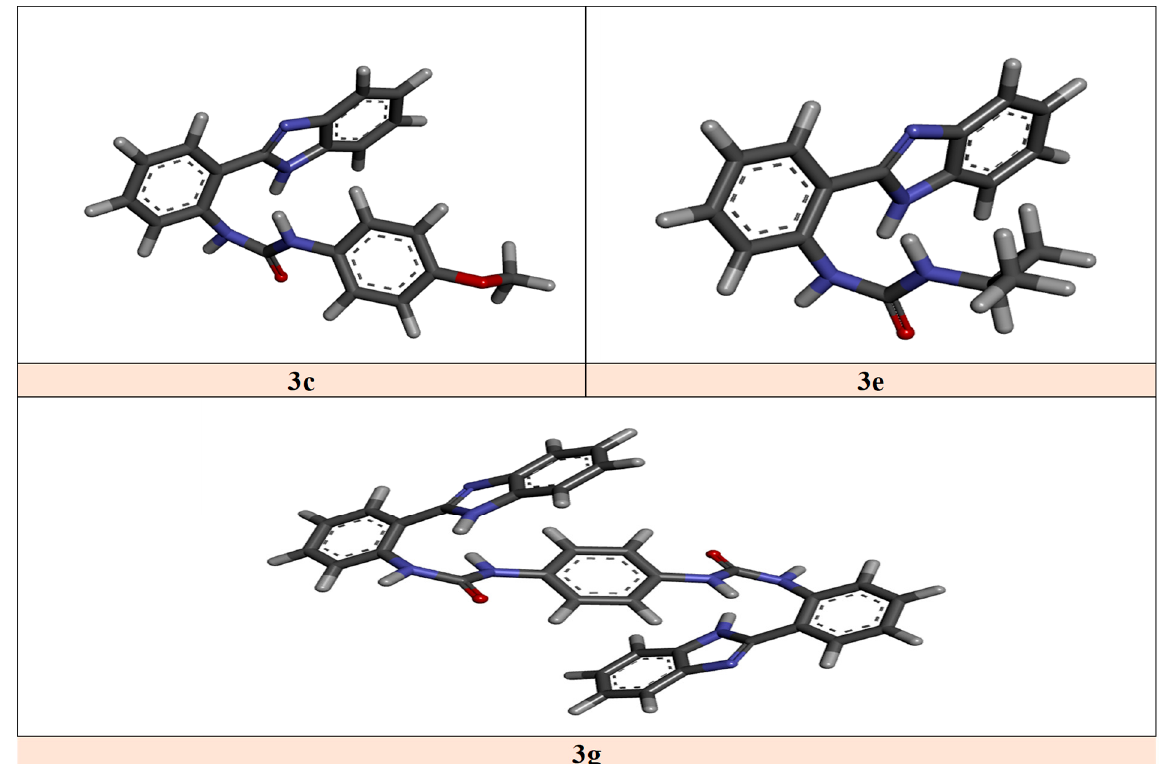
Figure 5 . Optimized structures of 3c , 3e , and 3g with Ammp calculations. Figure 5. Optimized structures of 3c , 3e , and 3g with Ammp calculations. Benzimidazole urea derivatives showed good values of binding energies with α - Table 4. Complexes with HPA and HLAG docking binding energies (kcal.mol − 1 ). amylase (HPA) human pancreatic and also the human lysosomal acid- α -glucosidase (HLAG) (Table 4). Compounds 3 α -Amylase (E Table 4 . Complexes with HPA and HLAG docking binding energies (kcal.mol − 1 ). Compounds 3